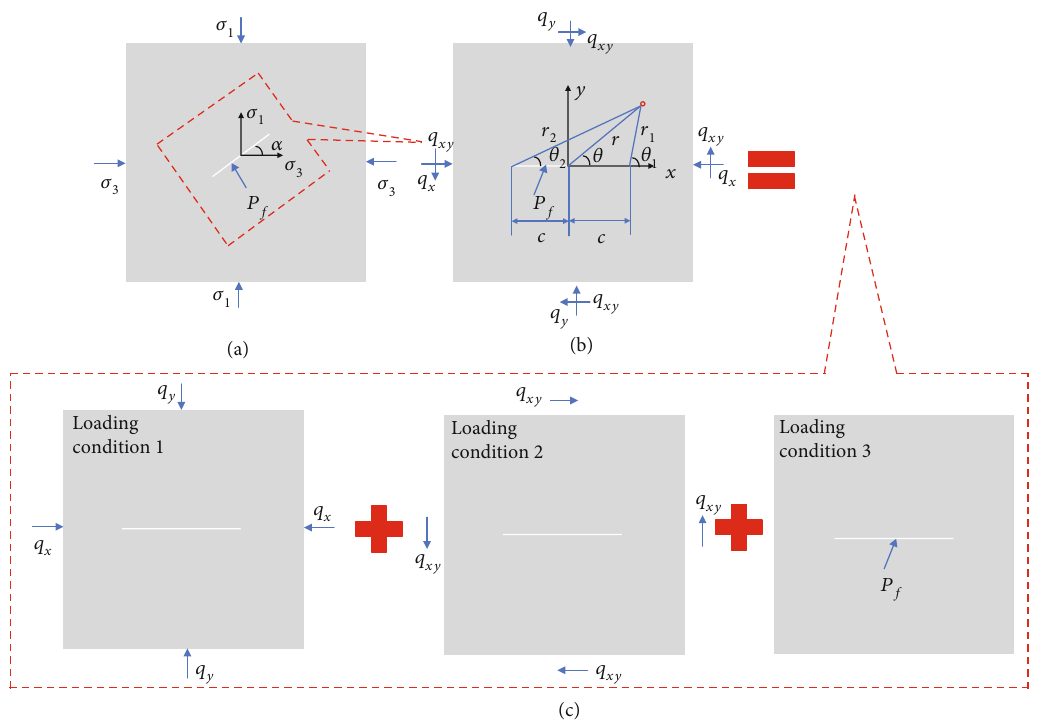
Figure 2: Illustration of the loading conditions on a rock mass containing a single